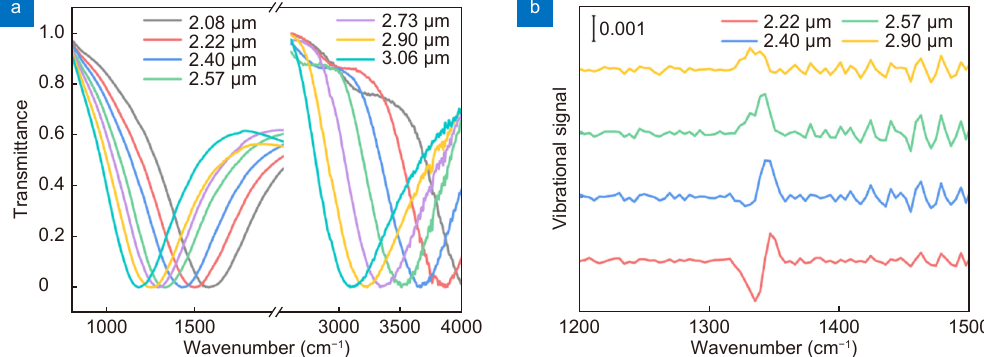
Fig. 5 | ( a ) Experimental transmittance spectra (normalized) as a function of the length of the NBRAs. ( b ) SEIRA spectra of PNTP on NBRAs with total lengths 2.22, 2.40, 2.57 and 2.90 μm in the range of the CTP